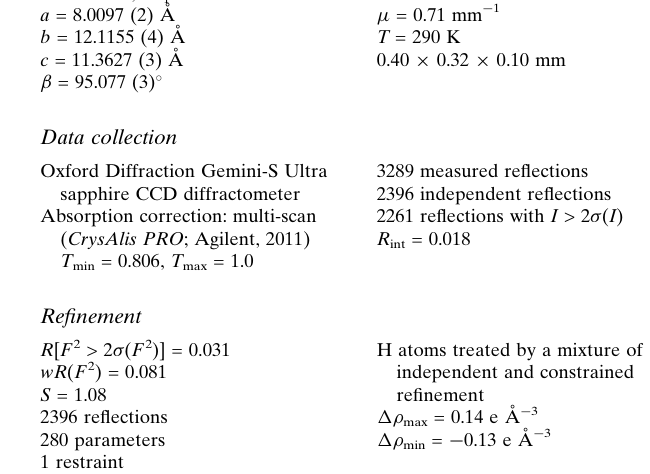
3289 measured reflections 2396 independent reflections